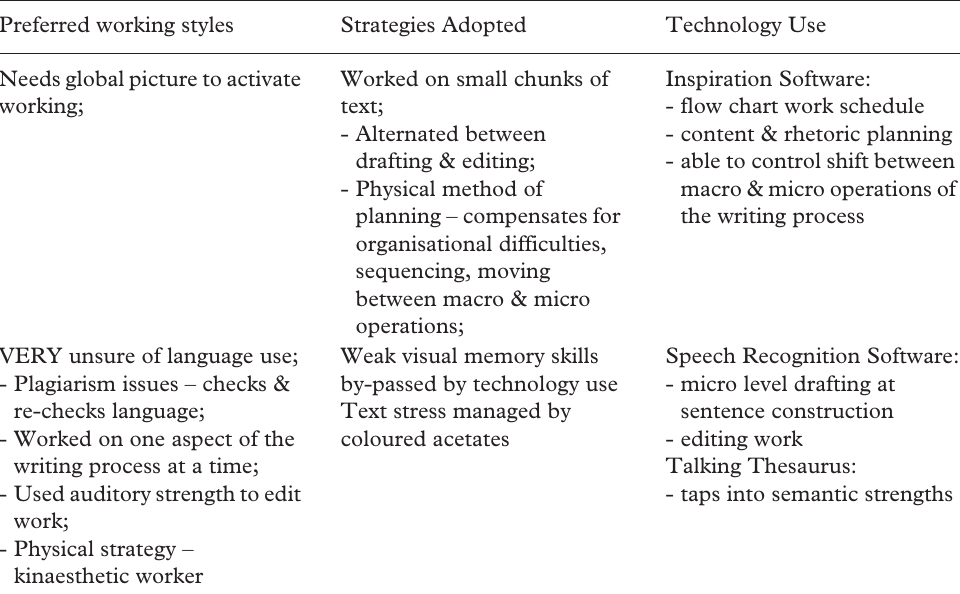
Table 1. Summary of strengths, technology and modal preferences of Student A Preferred working